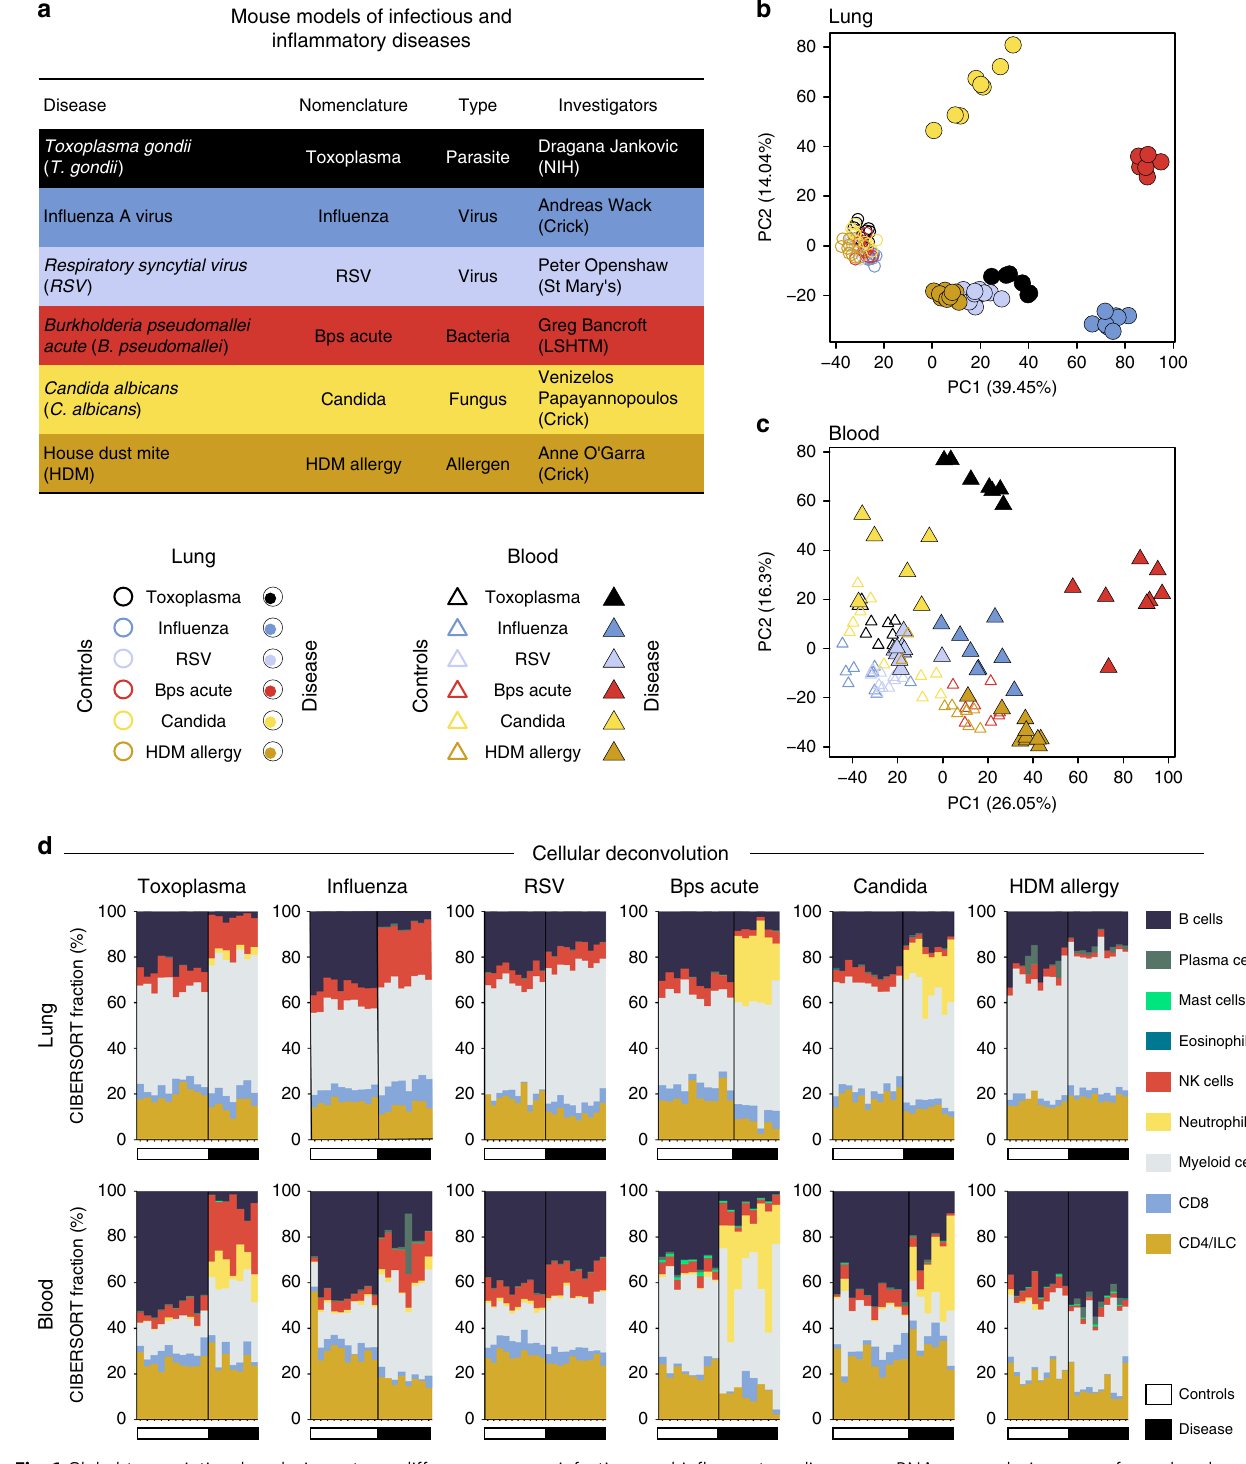
Fig. 1 Global transcriptional analysis captures differences across infectious and in fl ammatory diseases. a RNA-seq analysis was performed on lung and blood samples (Supplementary Data 1) obtained from experimental mouse models of 6 infectious and in fl ammatory diseases. b , c Principal component analysis in lung ( b ) and blood ( c ) samples, depicting the variation in the global gene expression pro fi les across diseases. Principal components 1 (PC1) and 2 (PC2), which capture the greatest variation in gene expression, are shown. Circles and triangles represent lung and blood samples, respectively, empty and fi lled symbols represent control and disease samples, respectively, and color represents mouse models. d Stacked bar plots depicting in silico immune cell composition of lung and blood RNA-seq samples, derived using the CIBERSORT algorithm based on cellular signatures obtained from ImmuCC. Each bar represents percent fractions for 9 representative cell types for an individual mouse sample, with colors representing the different cell types. White and black bars at the bottom of each plot represent control and disease samples, respectively. ILC innate lymphoid cells, NK cells natural killer